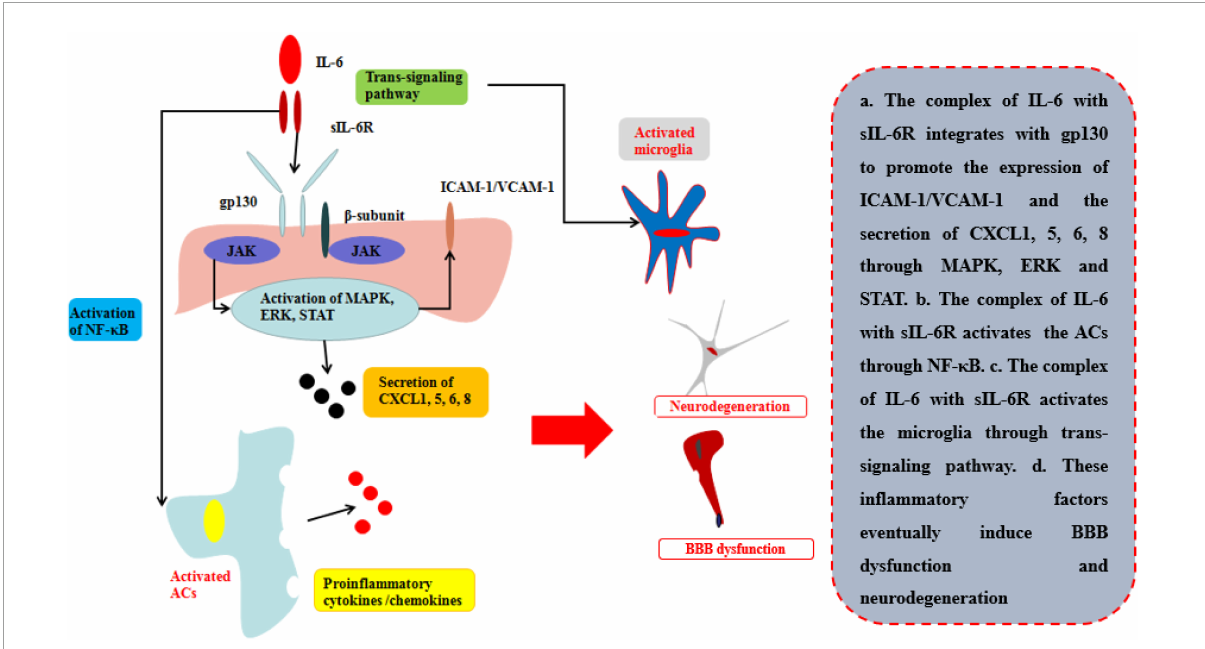
FIGURE5 Effects of IL-6 on BBB and neurological degeneration. The complex of IL-6 with sIL-6R integrates with gp130 to promote the expression of ICAM-1 and VCAM-1 on BMECs and the secretion of CXCL1, 5, 6, 8 through MAPK, ERK, and STAT. Moreover, the complex of IL-6 with sIL-6R activates the ACs through NF- κ B pathway to secrete pro-inflammatory cytokines and the microglia through trans-signaling pathway in CNS. Finally, these inflammatory factors eventually induce BBB dysfunction and